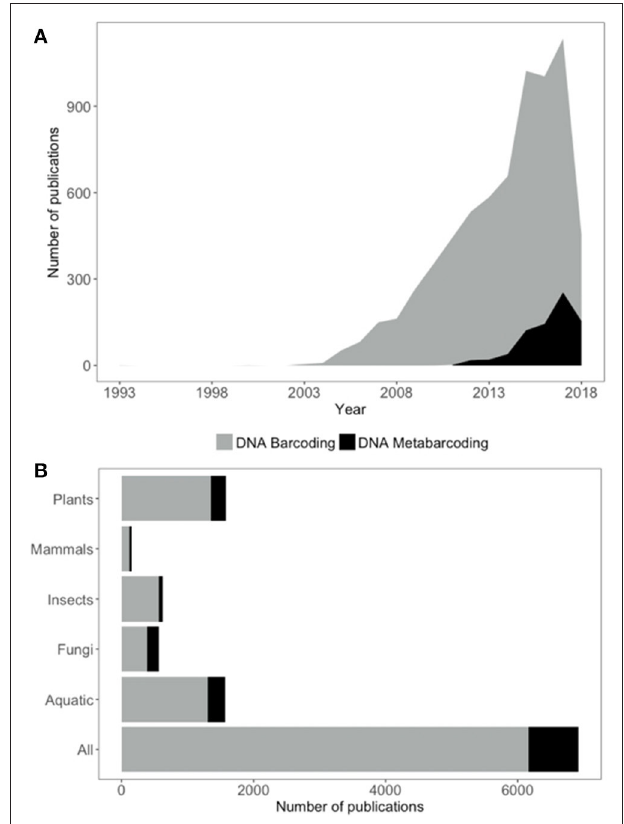
FIGURE 1 | Publication trends in DNA barcoding and metabarcoding from ISI Web of Science. (A) Number of publications per year for DNA barcoding (gray) and DNA metabarcoding (black). (B) Number of DNA barcoding (gray) and metabarcoding (black) publications for different groups of organisms. Database searches undertaken 6th June 2018. See Supplementary Data for exact search terms